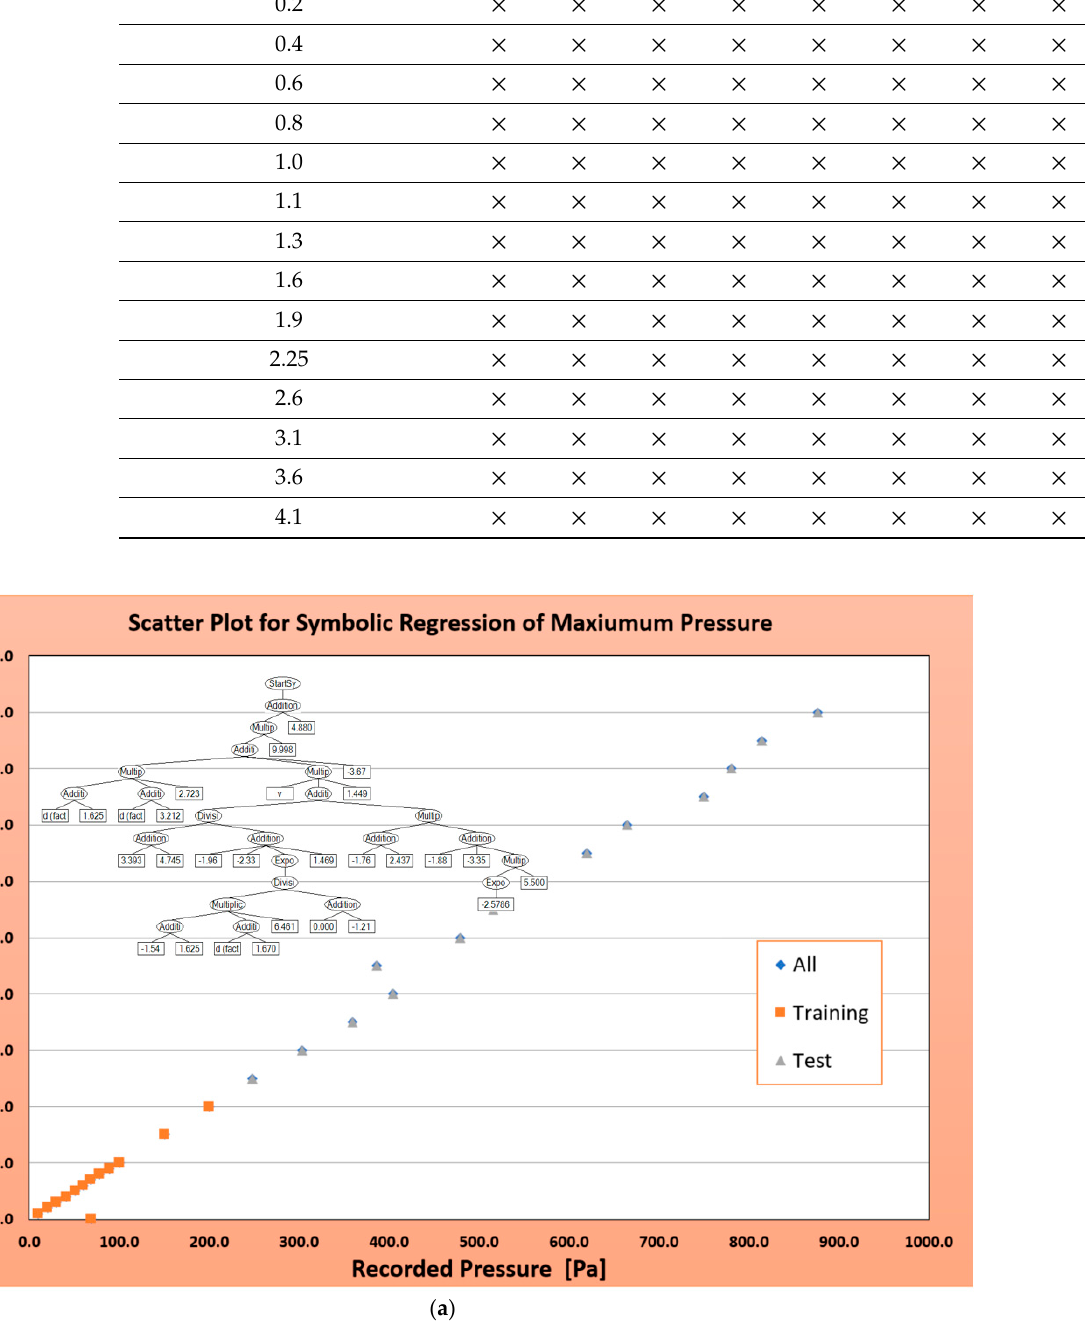
Table 1. Scenarios table for different vehicle speeds and distances. Vel. [mph] Distance [m]